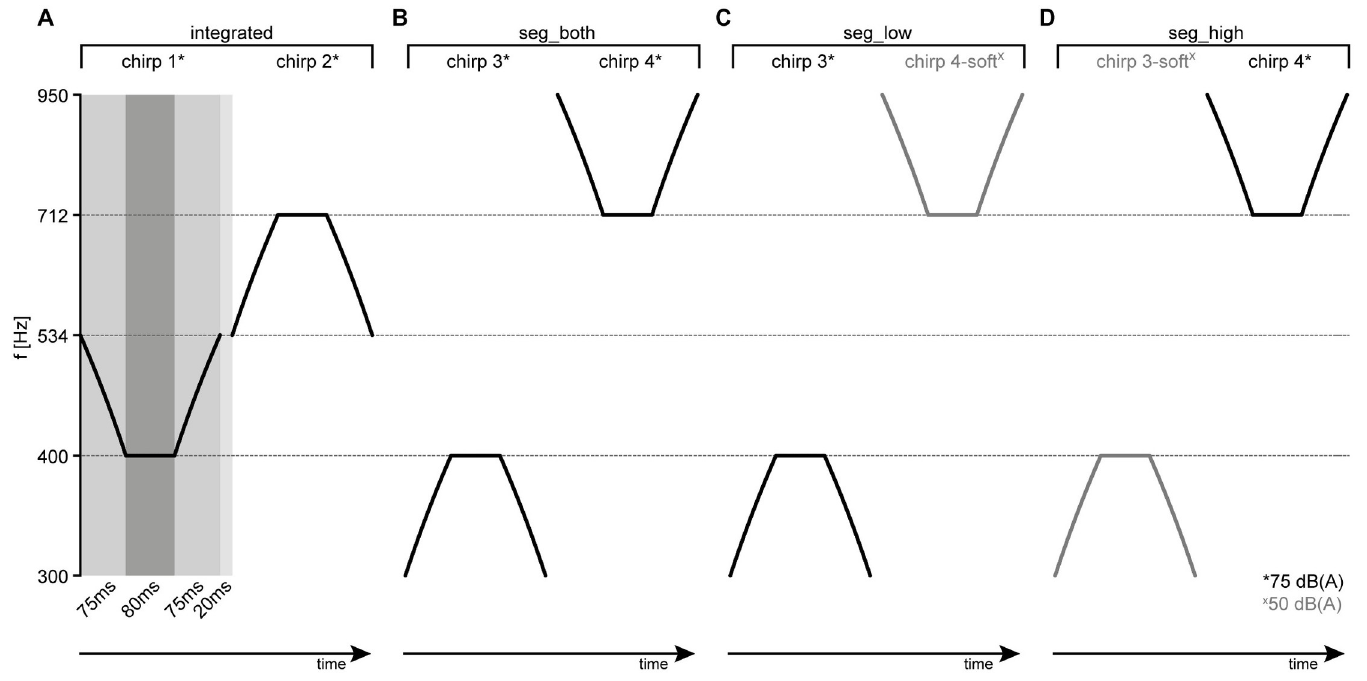
Fig 1. Sound design for the replay condition. A ) Sounds mimicking the integrated percept (“int”) consisting of repeating chirps 1 [sound A] and 2 [sound B]; with the drift of frequency inside the sound. B-D ) Sounds mimicking the segregated percepts. B ) “seg_both” (chirps 3 [tone A] and 4 [tone B]); C ) “seg_low” (chirps 3 [tone A] and 4-soft [tone B]) D ) “seg_high” (chirps 3-soft [tone A] and 4 [tone B]). Note that the spacing is uniform on a log scale (i.e., the frequencies represent steps of 5 semitones), while the sweep itself is linear in frequency, hence the slight curvature in log space. Chirps with reduced level (50dB(A)) are depicted in gray (chirps 3-soft and